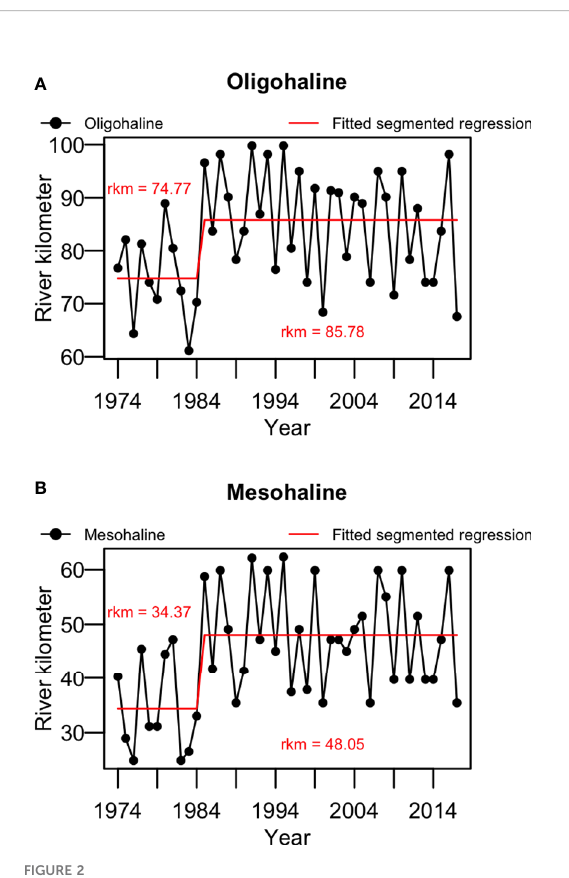
FIGURE 2 Time series of the locations of the upper limits of (A) oligohaline and (B) mesohaline of the Hudson River Estuary, during May-July in each year. The red lines indicate the fi tted segmented regression, and the red text indicate the average of river kilometer (rkm) in phase 1 (1974-1984) and phase 2